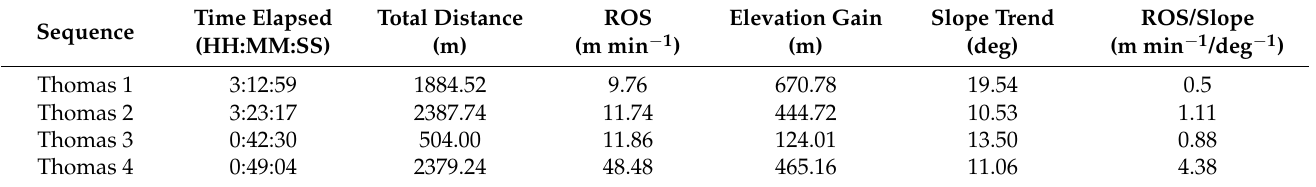
Table 6. Slope trend for Thomas fire sequences. Metrics in table summarize the full range of a sequences (time = 1 front to time = end front).